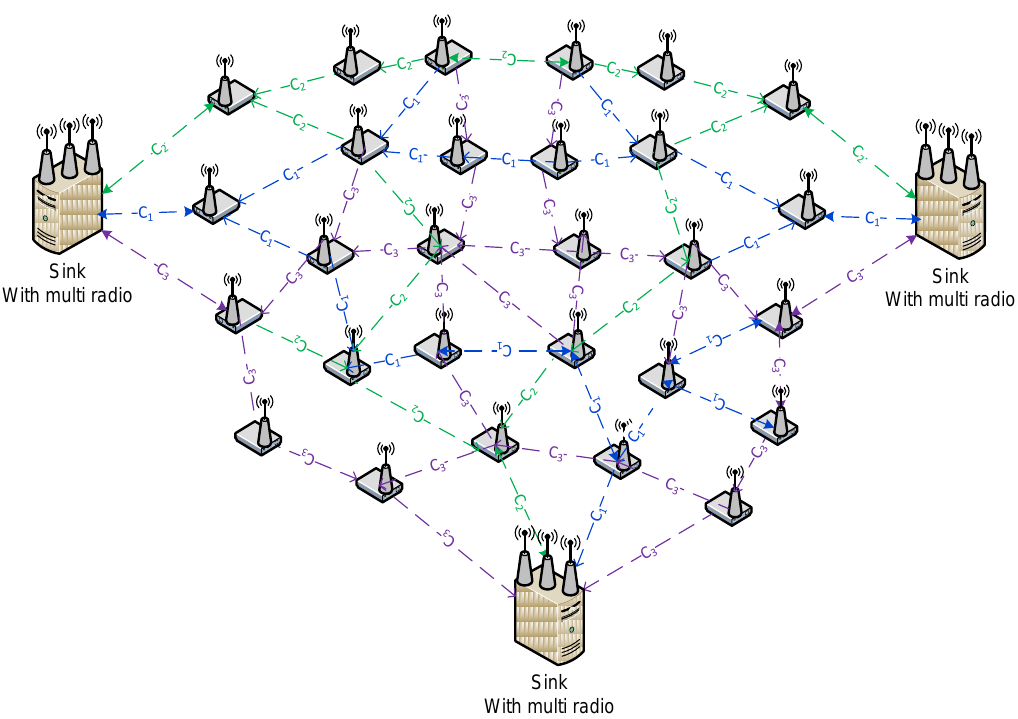
Figure 15. Multiple sink nodes with multiple radios.